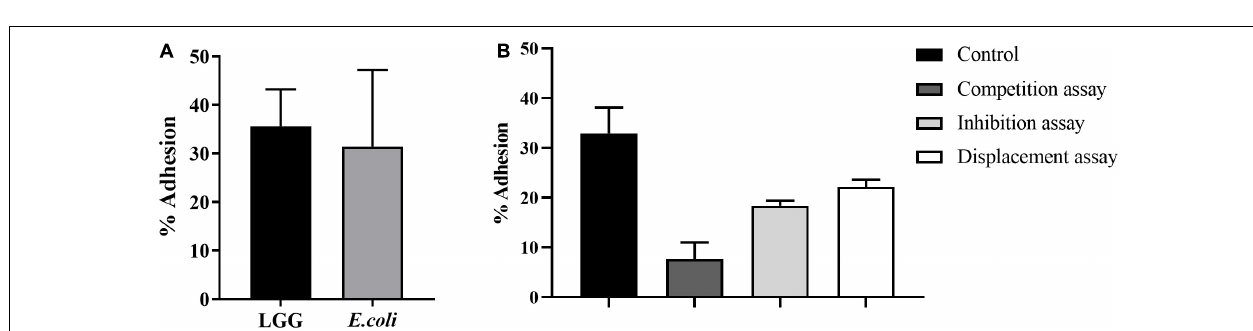
FIGURE 1 | Antibacterial activity of LGG against Staphylococcus aureus , Salmonella Paratyphi B, O1 E. coli , and Salmonella Enteritidis. Four pathogenic bacteria were spread onto the LB agar plates. Then (A) LGG culture supernatant, (B) lysate, (C) LGG culture, and (D) LGG cells were transferred to holes (5-mm diameter) punched into the agar palates. The antimicrobial activity was determined by the size of the inhibition zone. Bars represent the means ± standard deviations of three independent repetitions. Nd, not detected.